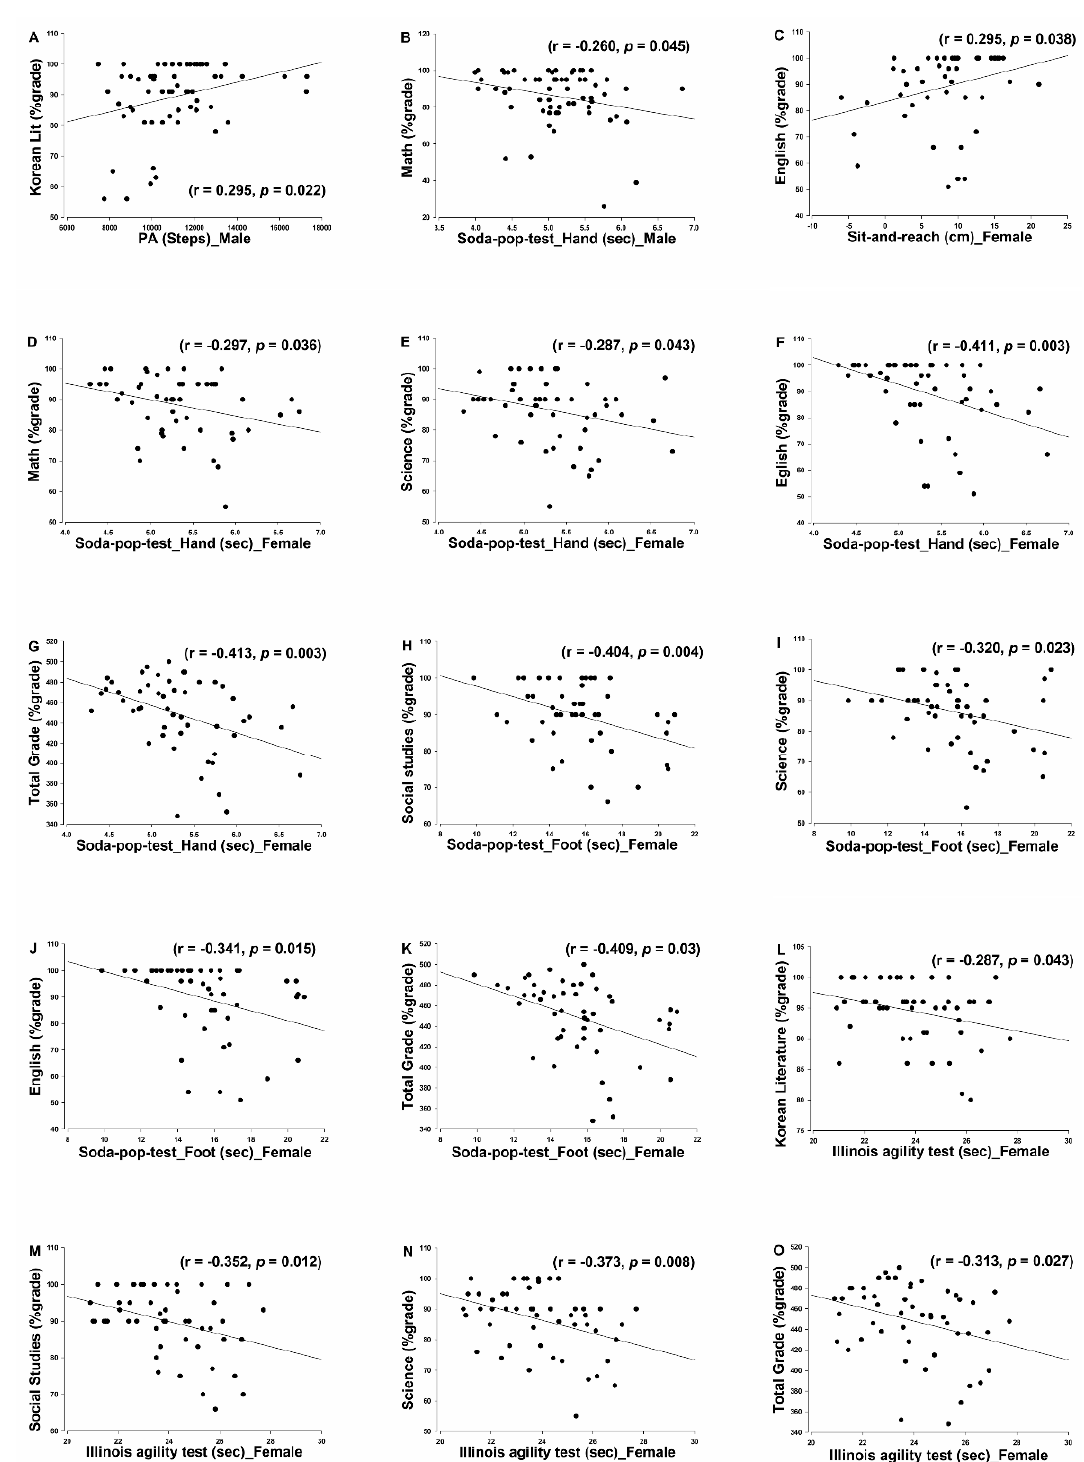
Figure 2. Scatterplots for the correlations that showed significant correlations between anthropometrics/PA/fitness tests and academic achievement scores.